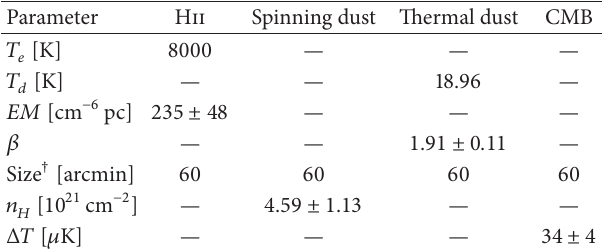
Radius of circular